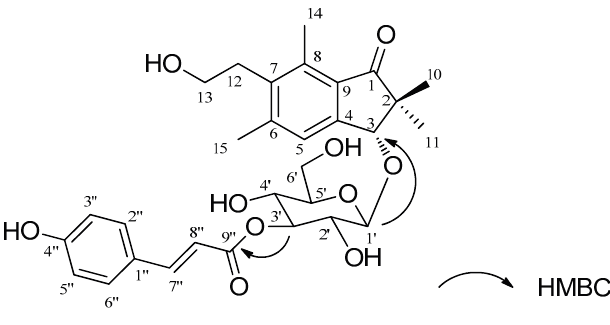
Figure 2. HMBC (heteronuclear multiple bond coherence) correlations for Compound 2